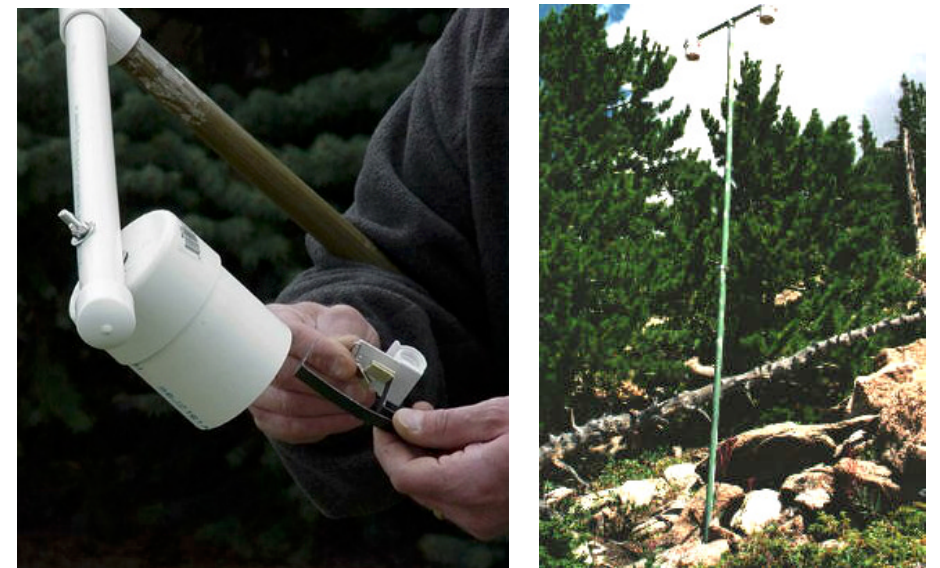
FIGURE 2 . Pictures of the field equipment used with the passive sampler badges. Left: Rainshield and clip to hold badges. Right: sampling system pole with two rainshields in field use. The sampling systems are placed in clearings such as the rock field shown. The poles and the outside of the rainshields are painted to blend into the